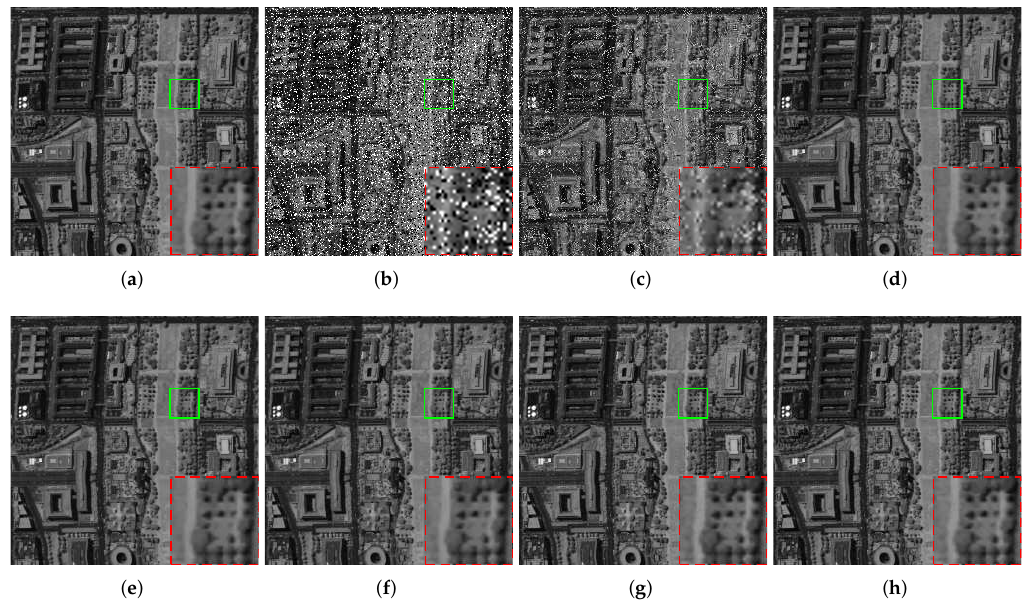
Figure 5. Restoration results of band 59 for WDC dataset (the red box illustrates the zoom-in portion in the blue box). ( a ) Noisy-free image; ( b ) noisy image (PSNR = 11.94 dB); ( c ) BM4D (PSNR = 17.55 dB); ( d ) LRMR (PSNR = 34.40 dB); ( e ) LRTV (PSNR = 35.51 dB); ( f ) 3DTVLR (PSNR = 36.52 dB); ( g ) LRRSDS (PSNR = 33.97 dB); ( h ) SDTVLA (PSNR = 37.67 dB).